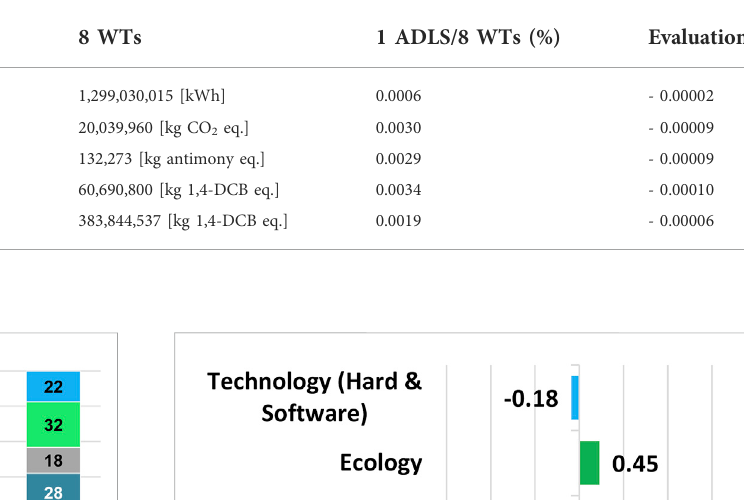
TABLE 1 Normalization of LCA results to MCA evaluation scale.